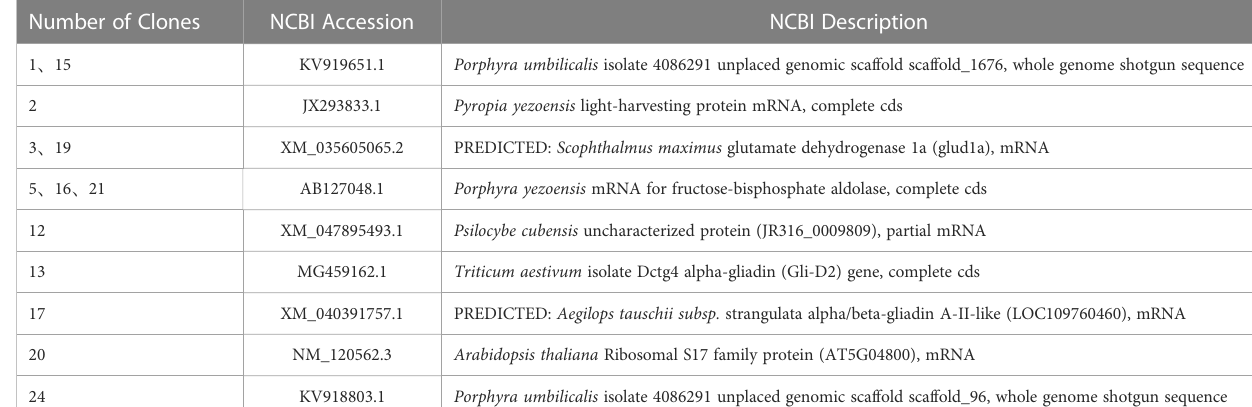
TABLE 3 Positive clones that encoding different proteins.